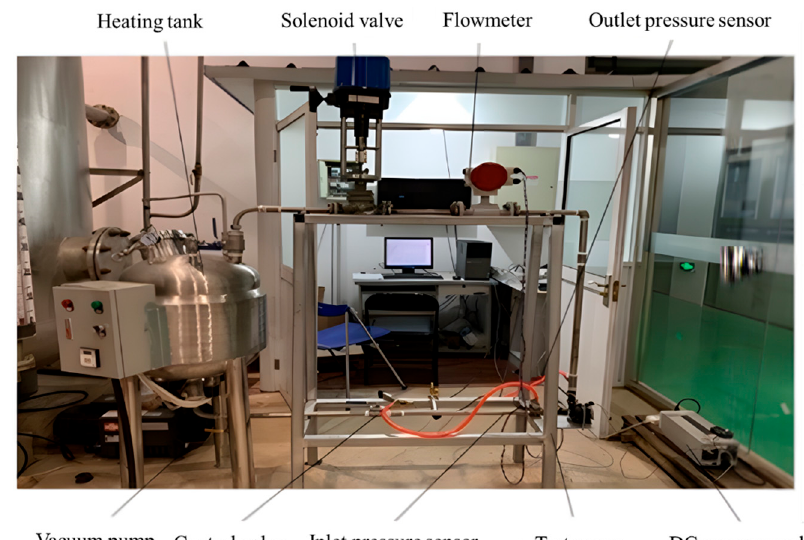
Figure 1. Experimental set-up diagram.